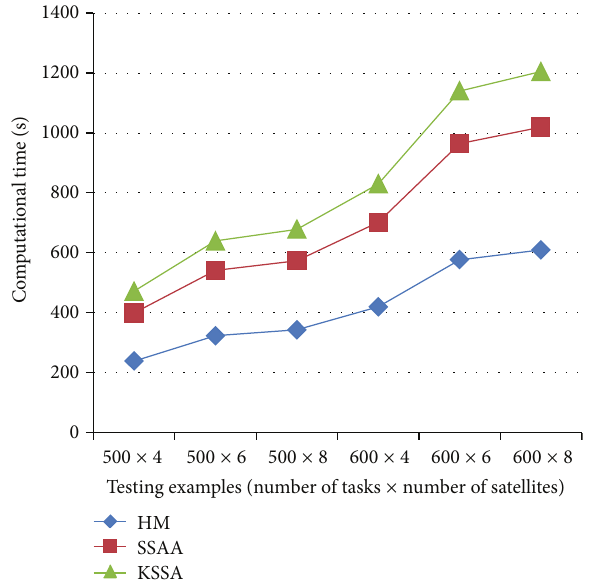
Figure 8: Experimental results in computational time of large scale testing